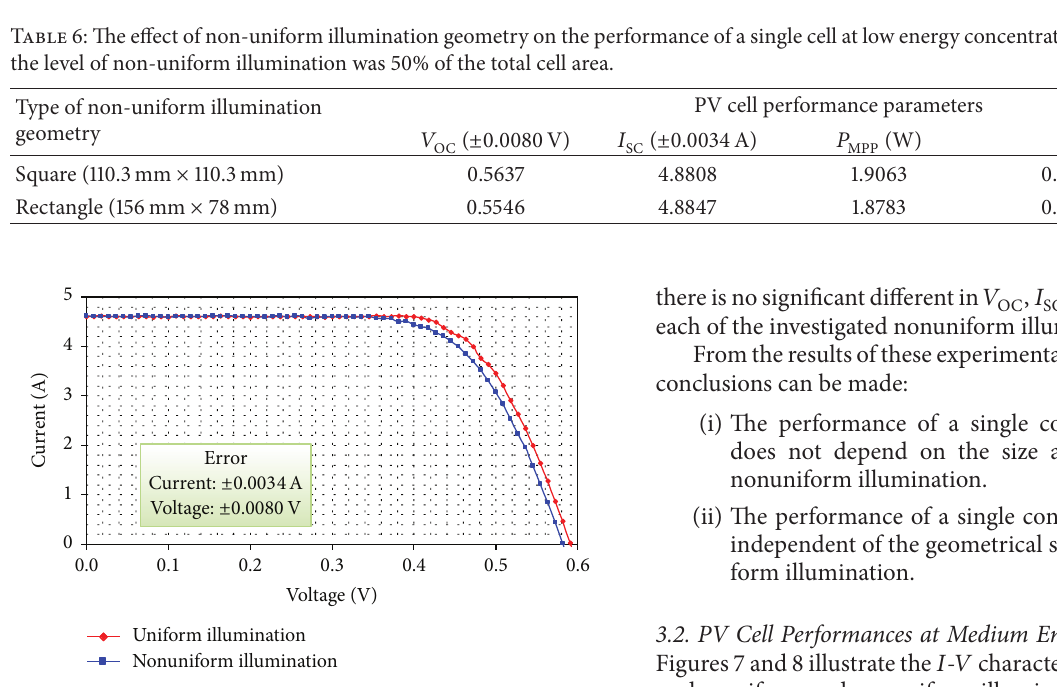
Figure 5: 𝐼 - 𝑉 characteristics for a single PV cell when uniformly and nonuniformly illuminated at low energy concentration ratio. The area occupied by nonuniform illumination was 50% of the total cell area.